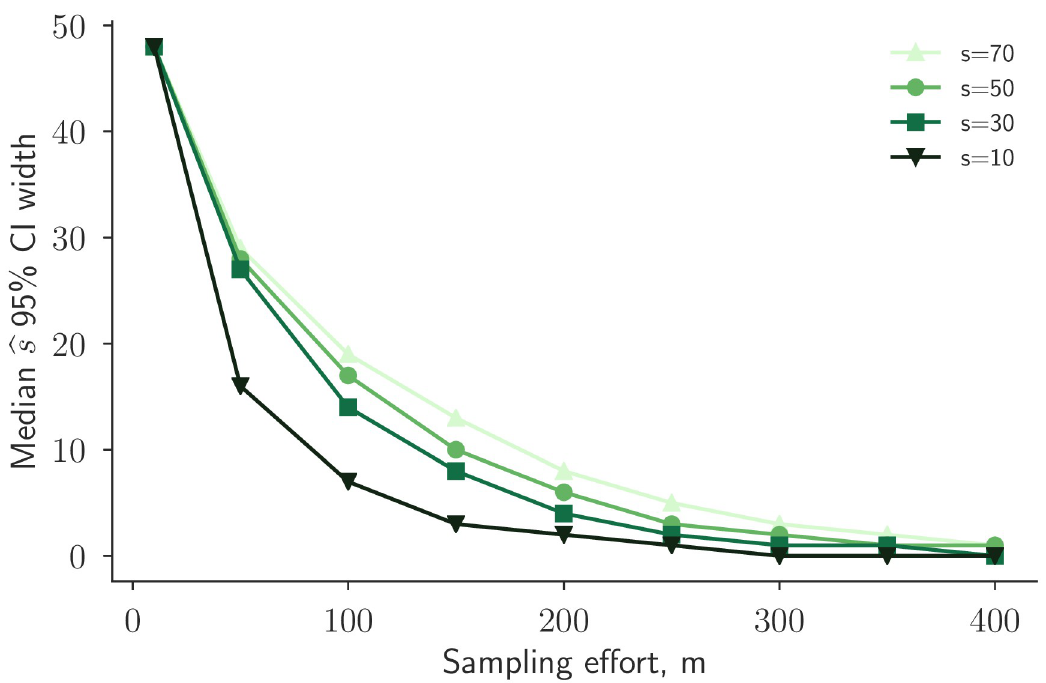
Fig 6. Quantifying the decrease in uncertainty from increased sequencing. Constant s curves show the median 95% credible interval (CI) width for the s estimate, b s , as a function of the sampling effort m across 300 count data generation simulations. This plot illustrates the intuition that additional laboratory efforts (increasing m ) lead to higher accuracy (smaller CIs).